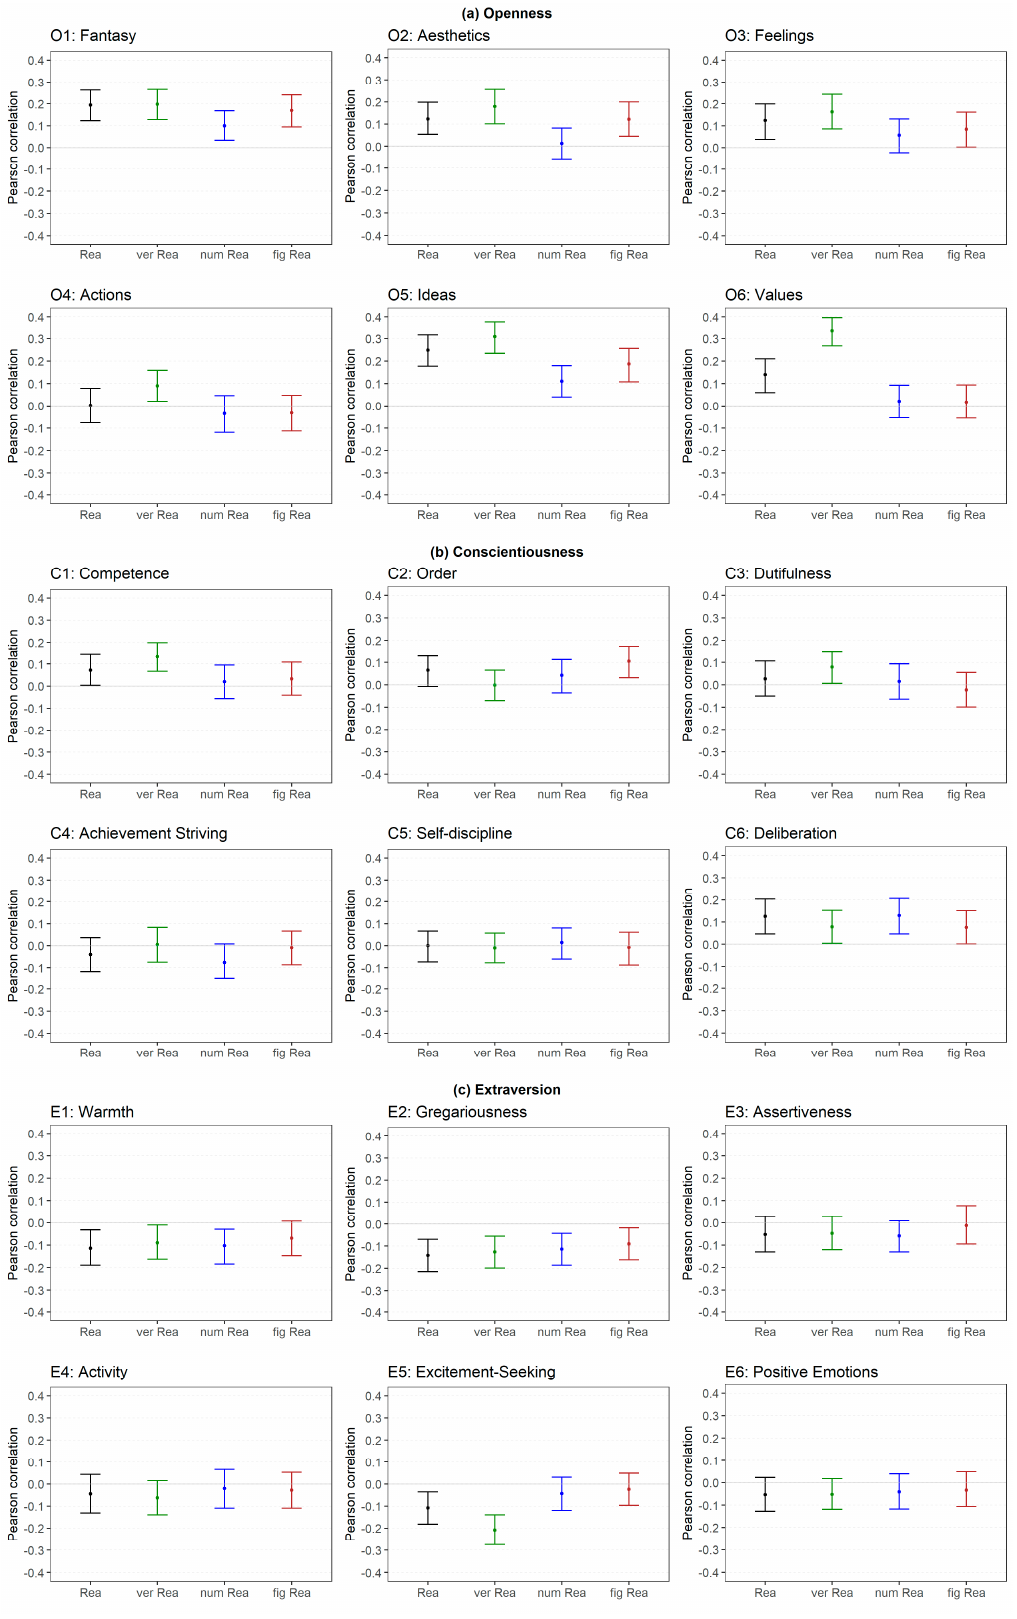
Figure 4. Study 1: Correlations between reasoning and the facets of ( a ) Openness, ( b ) Conscientiousness and ( c ) Extraversion. Rea = reasoning, ver = verbal, num = numerical, fig = figural.